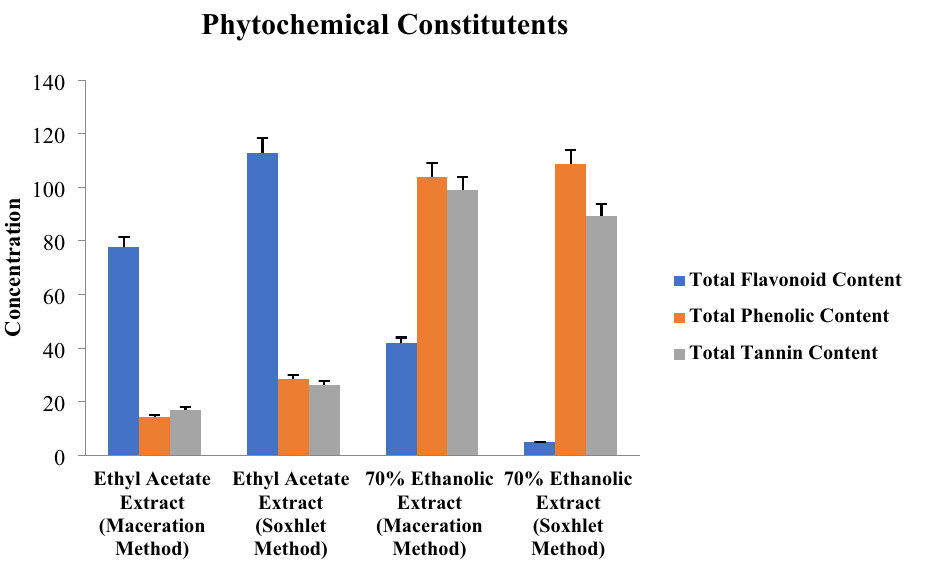
Figure 2. Comparative quantitative analysis of phytochemical constituents found in seed extracts prepared with 70% ethanol and ethyl acetate employing soxhlet and maceration extraction